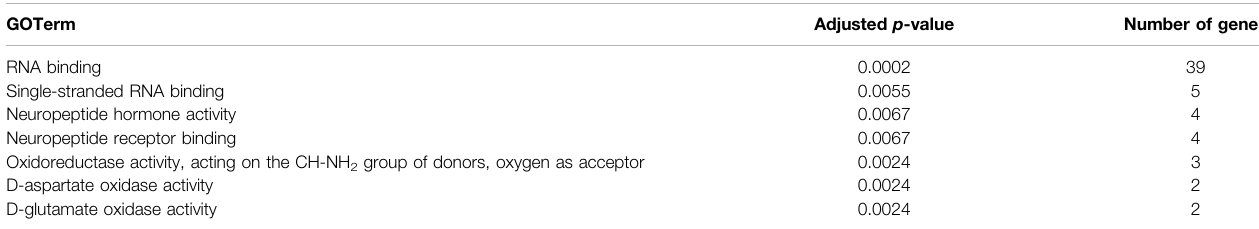
TABLE 4 | GO Term Analysis for AS-NMD Regulated Genes in C. elegans . GOTerm RNA binding